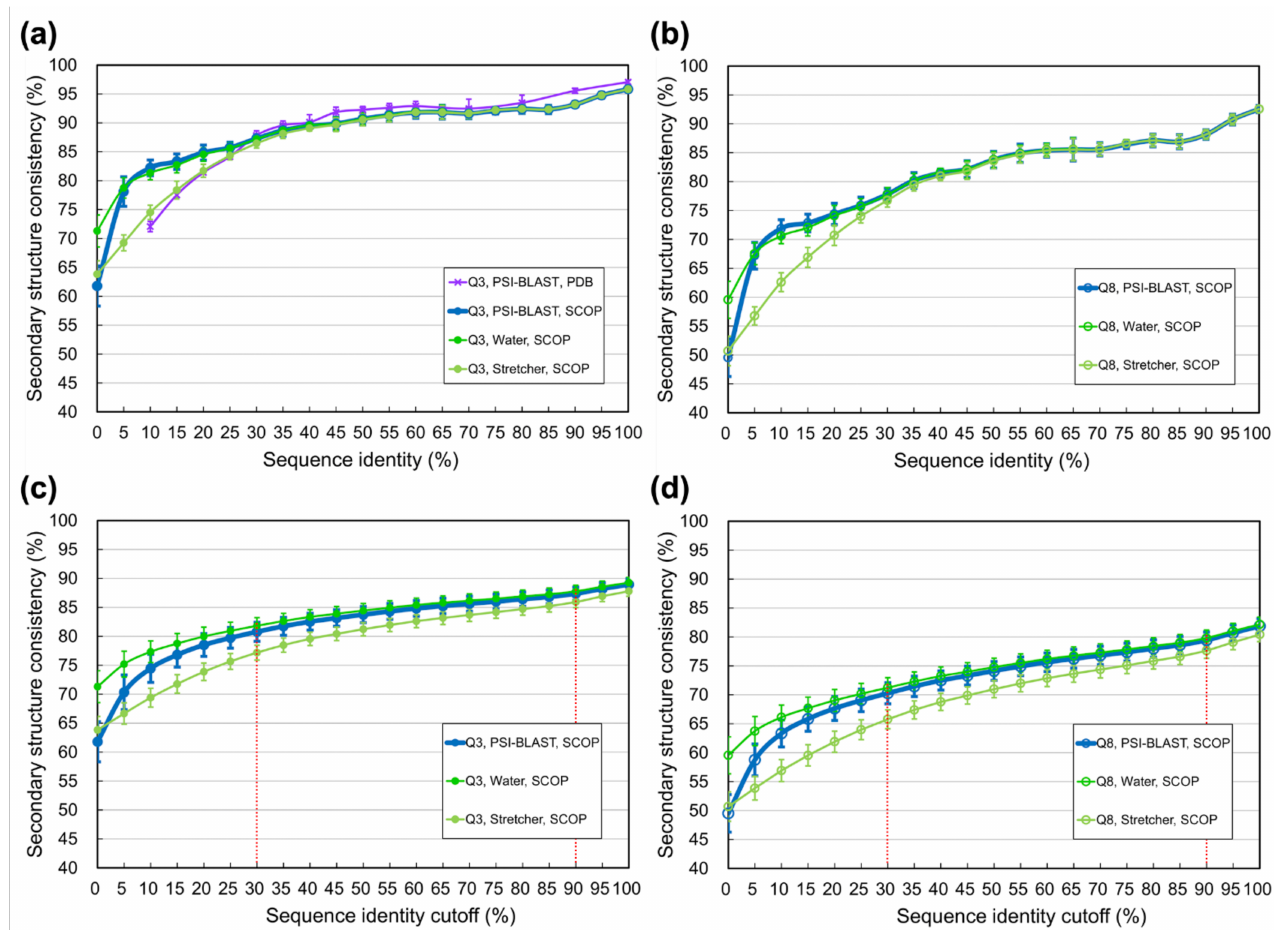
Figure 2. Secondary structural consistency measured by sequence alignments between structural homologs verified by SCOP. ( a ) Three-state secondary structural consistency (Q3) at various sequence identity levels. Using the structural homologs determined by SCOP to repeat the experiment of previous studies, the Q3 data of homologs sharing ≥ 30% identity were very similar to previous results. The purple curve of PSI-BLAST and PDB is obtained from Figure 1a for comparison. The Q3 differed significantly at low identities, with SCOP-determined homologs being much higher than PSI-BLAST-identified ones. Note that the difference was mainly caused by how homologs were defined (manual curations vs. programmatic searches) rather than by the source of data (SCOP vs. PDB). The Q3 was measured by PSI-BLAST, classic BLAST, Water, and Stretcher. The classic BLAST was omitted in this figure for clarity because its curve lay closely to that of PSI-BLAST (see Table S3 for full data, with the classic BLAST included). ( b ) Eight-state secondary structural consistency (Q8) at various sequence identity levels. ( c ) Q3 at various sequence identity cutoffs. The horizontal axis indicates the cutoff where, for instance, 30 and 90 mean that the identities of homologous structures are lower than 30% and 90%, respectively. Since protein datasets are typically prepared as nonredundant sets of identities lower than given cutoffs in practical research, in all figures after this, we only display the consistency computed under given identity cutoffs instead of thresholds. ( d ) Q8 at various sequence identity